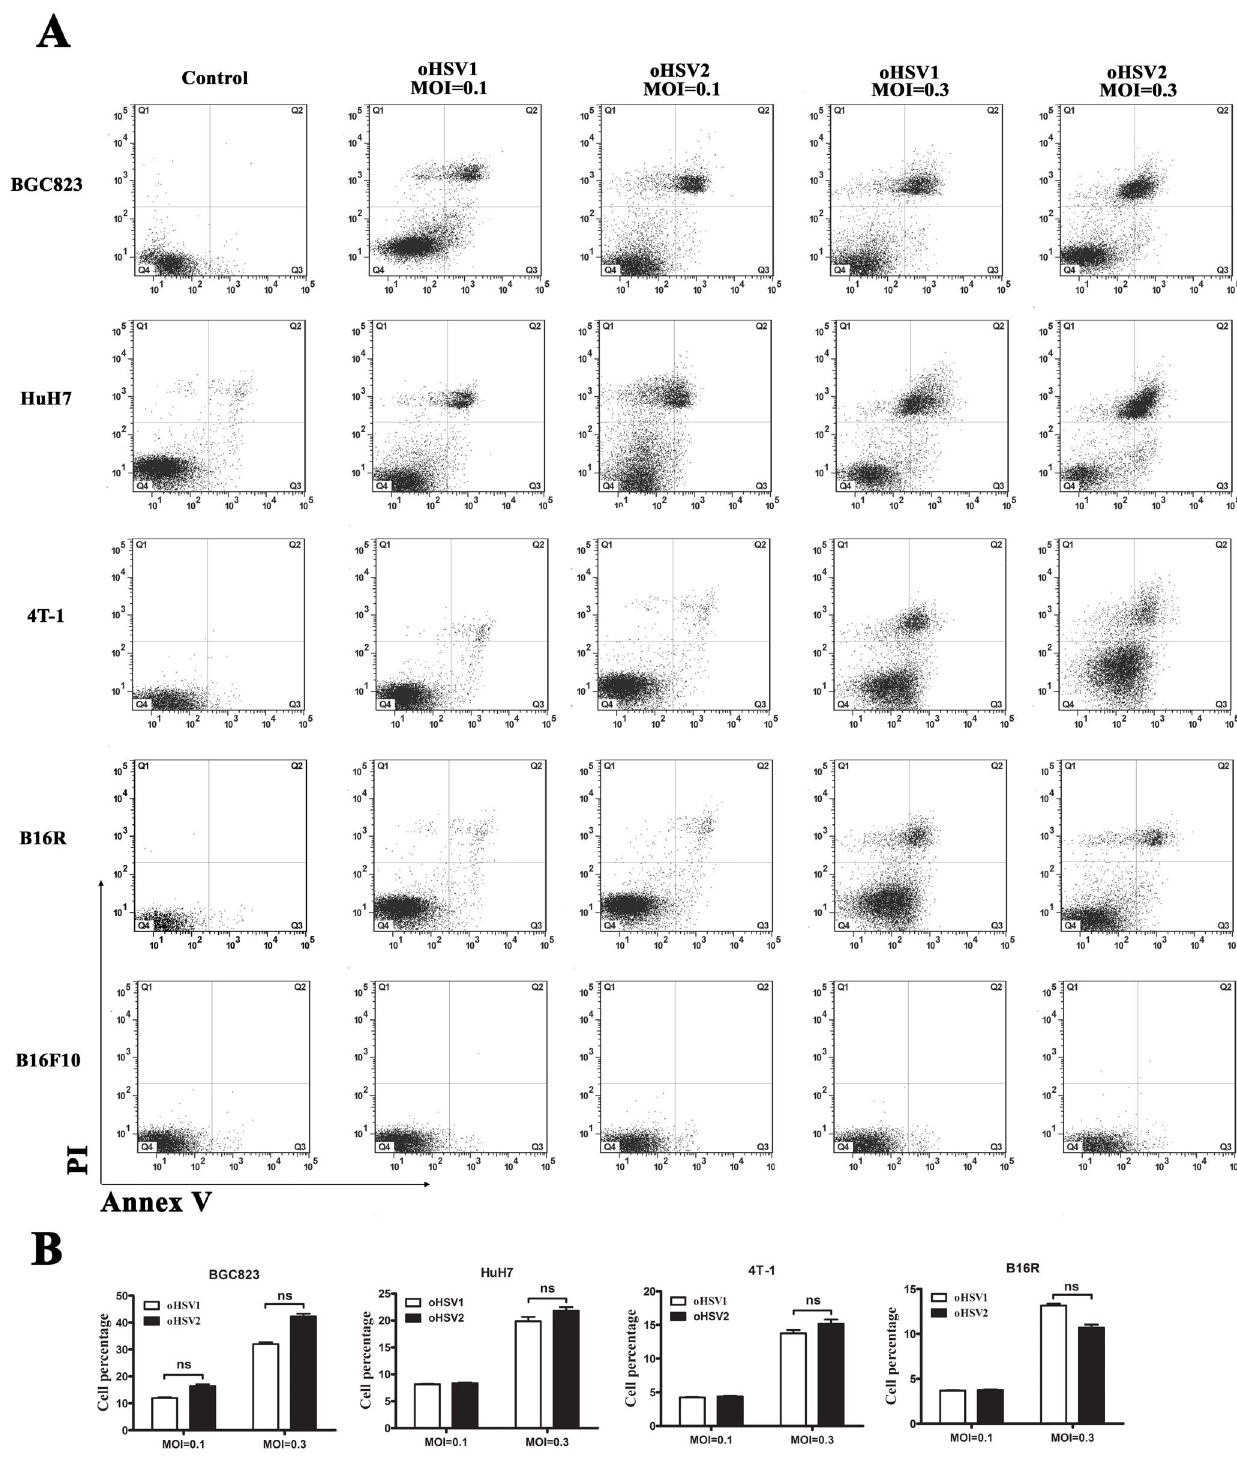
Figure 4. Invitro comparison of oHSV2 with oHSV1. Both oHSV1 and oHSV2 induces necrosis in cancer cells. A) Flow cytometry analysis of cancer cell lines after oHSV2 or oHSV1 infection at the indicated MOIs for 24 h. B) The necrosis rates of the cancer cell lines were measured after oHSV2 or oHSV1 infection. Each value represents the mean 6 SED of three independent samples. ns, no significant differences.